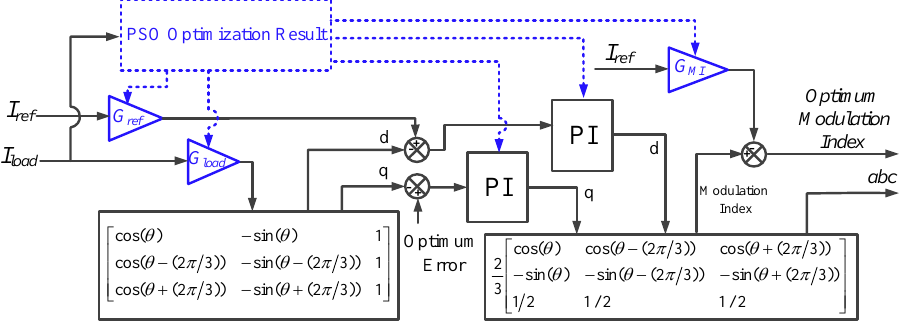
Figure 6. Particle Swarm Optimization-PI (PSO-PI) controller.